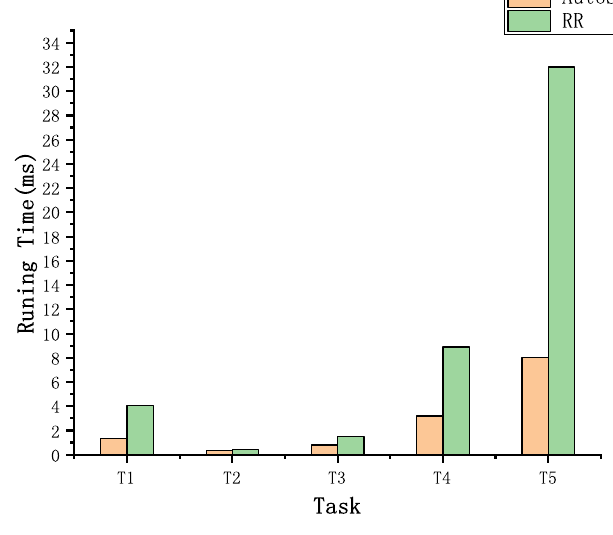
Figure 5. The average running time for each task with different scheduling algorithms executed by 30